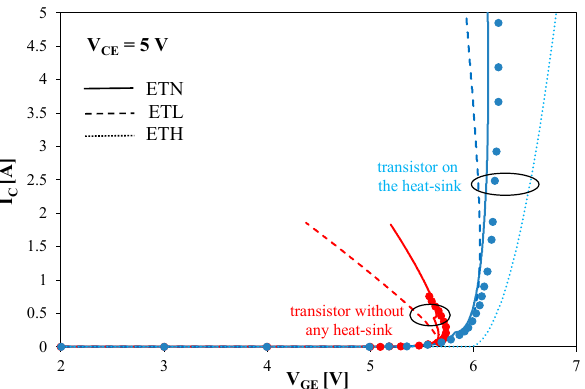
9 of 17 Figure 4. Computed and measured output characteristics of the tested transistor operating at strong steering ( a ) and de- pendences of the case temperature on voltage V CE ( b ). Cooling conditions strongly influence the dependence T C (V CE ) shown in Figure 4b. This dependence is an increasing function. At the collector current equal to about 3 A (at V CE = 1.2 V), the transistor without any heat-sink attains the case temperature equal even